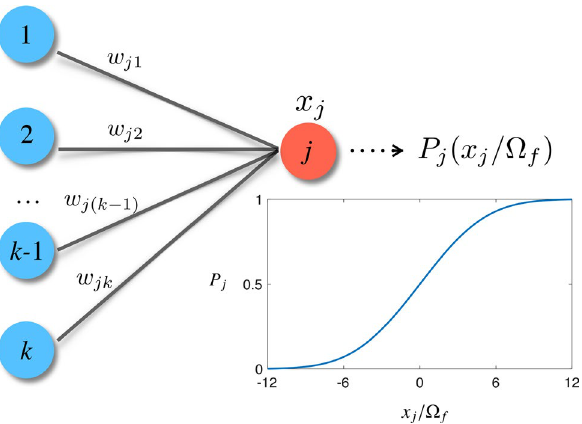
Figure 1. Schematic configuration of a quantum perceptron. When it is integrated in a feed-forward neural network, the potential depends on neurons in earlier layers, e.g., function of the quantum perceptron is the probability of the excited state P j ( x j /� f ) at the final time t form of sigmoid-shape, shown in the